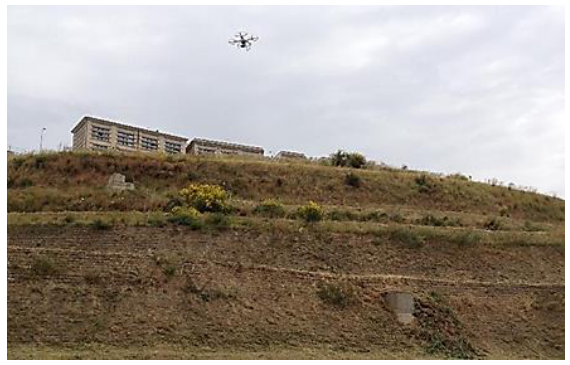
Figure 3. UAV flying in survey phase